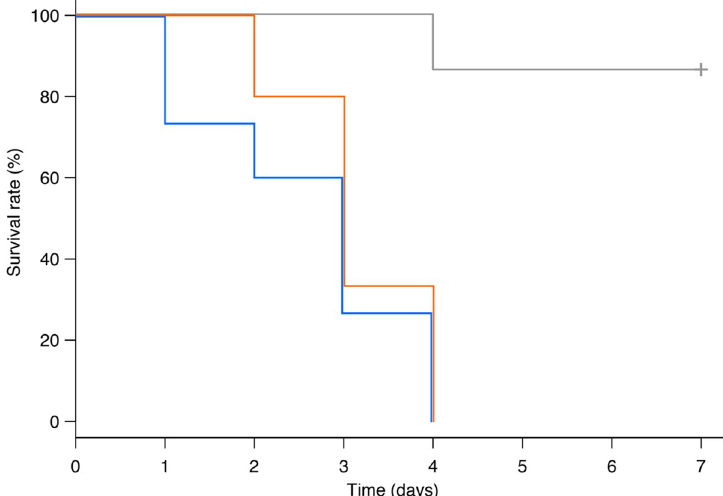
Fig 3. Survival rates of aphids treated with diaphorin or pederin. Kaplan–Meier survival curves of aphids treated with 5 μ M diaphorin or pederin (diaphorin: orange; pederin: blue; control: grey). Data derived from three independent experiments (total of 15 individuals per treatment) were pooled and plotted on a single graph. The vertical tick mark indicates the censored time. The log-rank test and the Holm–Sidak test confirmed there were significant differences between the control and diaphorin treatment ( p < 0.001) and between the control and pederin treatment ( p < 0.001).